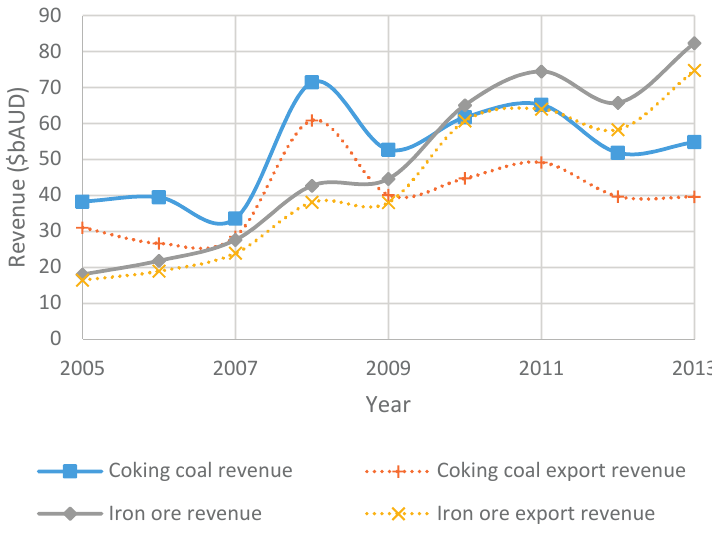
Figure 1. Australian industry revenues for iron ore and metallurgical coal since 2005